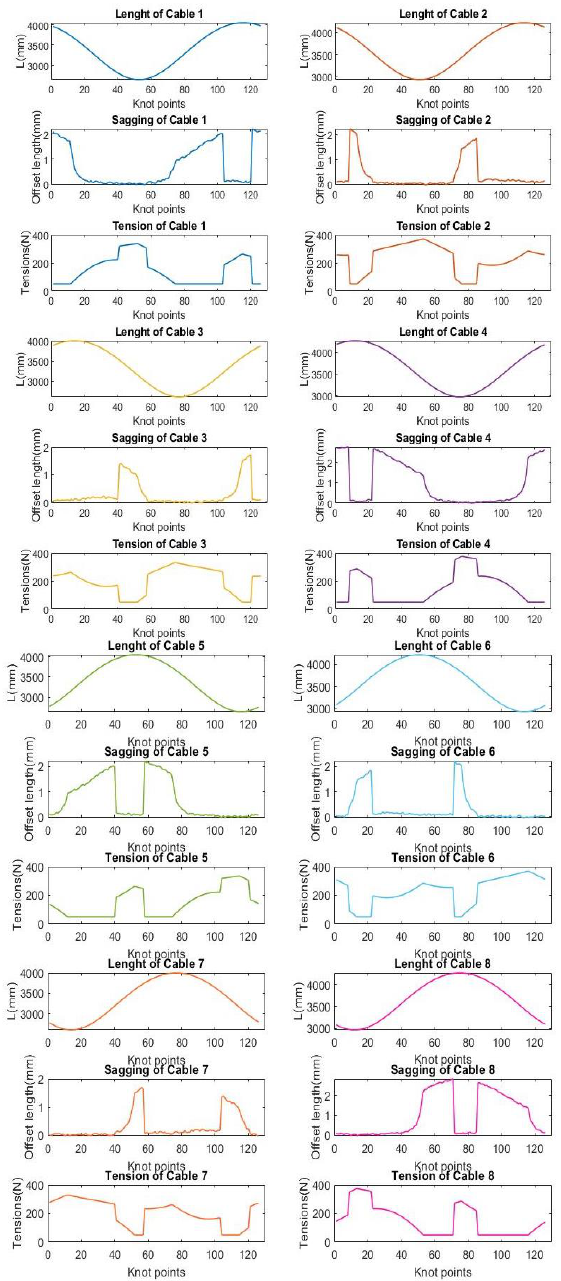
Figure 9. Offset length vs. tension of Cables 1–4 for circle interpolation (r = 0.8 m).